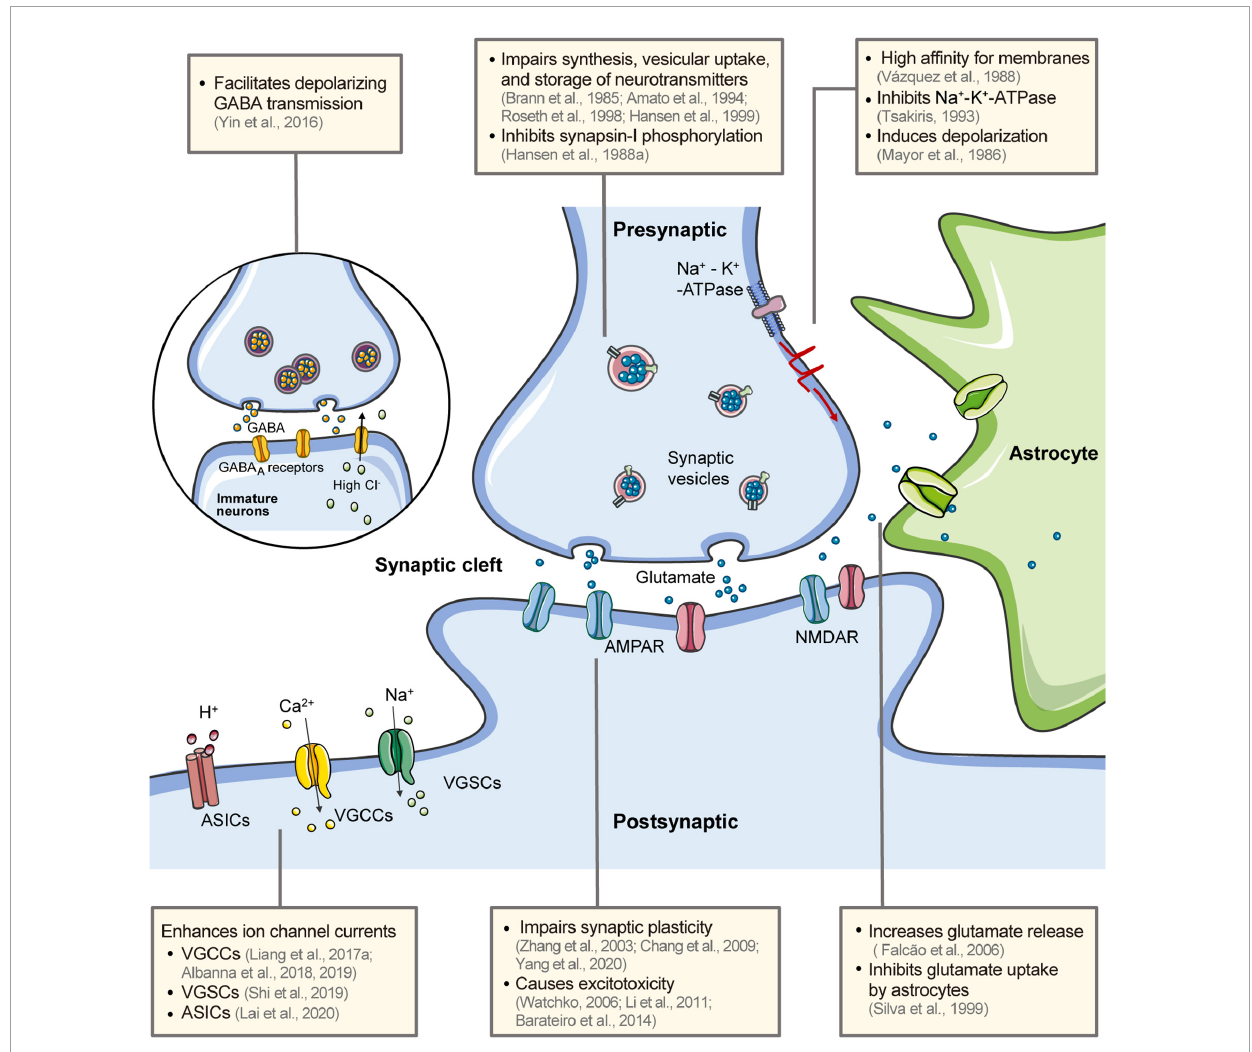
FIGURE2 Effects of bilirubin on neural electrical activity. It interferes with the synthesis, uptake, storage, and release of neurotransmitters in the presynaptic terminal. Glutamate release is increased and astrocyte uptake is inhibited. The excess glutamate causes excitotoxicity in postsynaptic neurons via glutamate receptors. Synapse plasticity is also impaired by bilirubin. In immature neurons, bilirubin facilitates transmission in GABAergic synapses and contributes to the hyperexcitability of postsynaptic neurons. Bilirubin can directly affect several ion channels in neurons, including VGCCs, VGSCs, and ASICs. Bilirubin has a high affinity for the membrane and induces rapid depolarization and inhibits the Na + -K + -ATPase (Mayor et al., 1986; Vazquez et al., 1988). GABA, gamma-aminobutyric acid; AMPAR, α -amino-3-hydroxy-5-methyl-4-isoxazolepropionic acid (AMPA) receptors; NMDAR, N-methyl-D-aspartate (NMDA) receptors; ASICs, acid-sensing ion channels; VGCCs, voltage-gated calcium channels; VGSCs, voltage-gated sodium